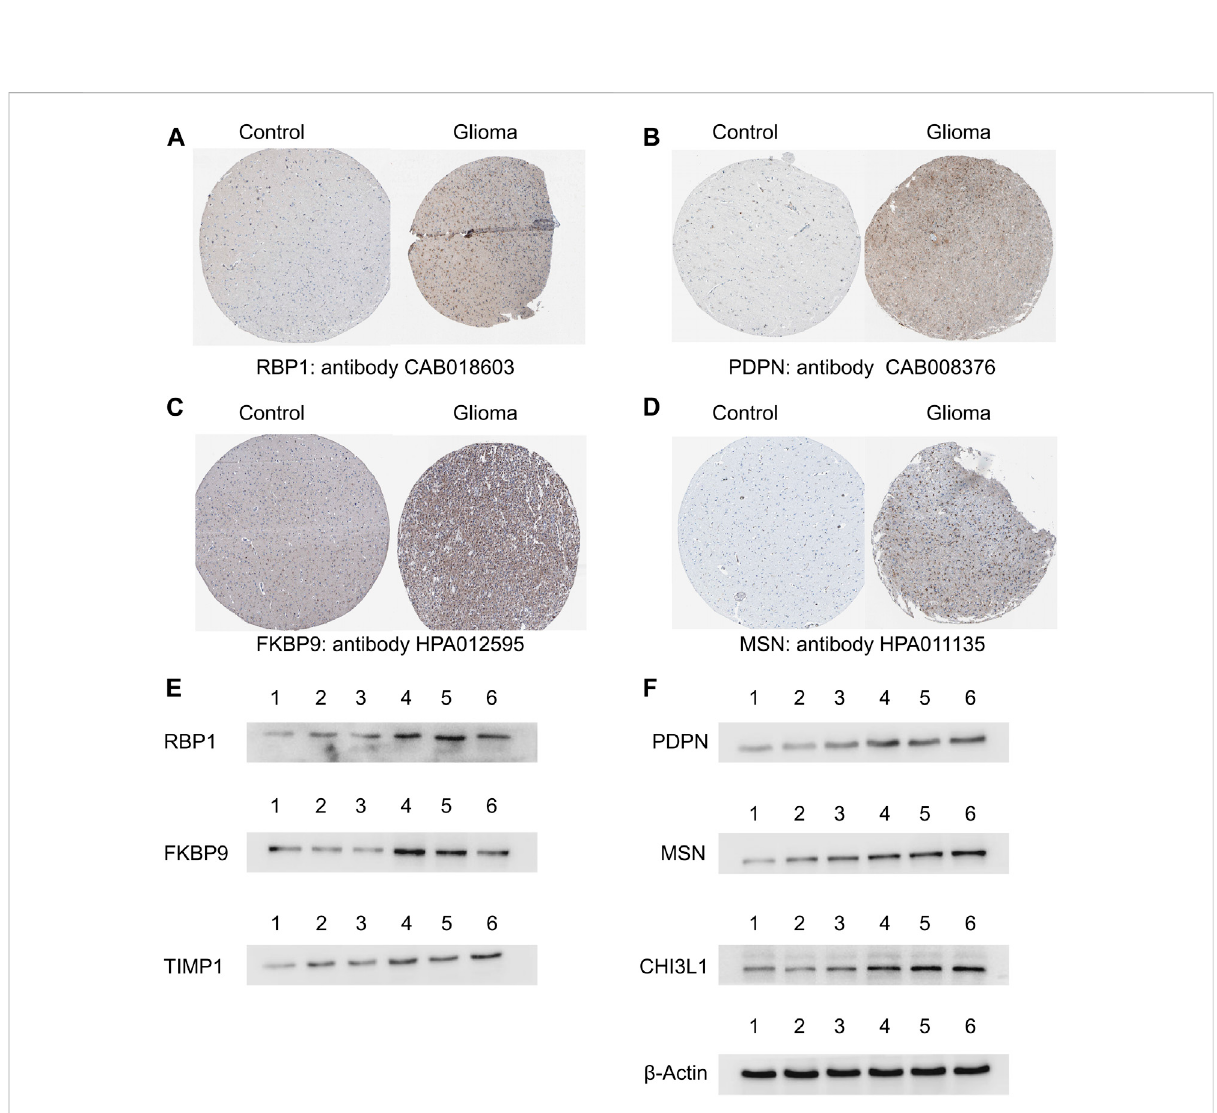
FIGURE 9 Validation of the featured ACAFRGs at the protein level. (A – D) Differential expression patterns of the featured genes between normal brain tissues and glioma tissues which were identi fi ed in immunohistochemistry staining on the Human Protein Atlas website. (E) Identi fi cation of the featuredgenesbyWesternblotting,inwhichlane1representsnormalbraintissues,lanes2and3representgradeIIgliomatissues,andlanes4,5,and 6 represent grade III glioma tissues. ACAFRGs, aging cancer-associated fi broblast related genes; Control: normal brain tissue.